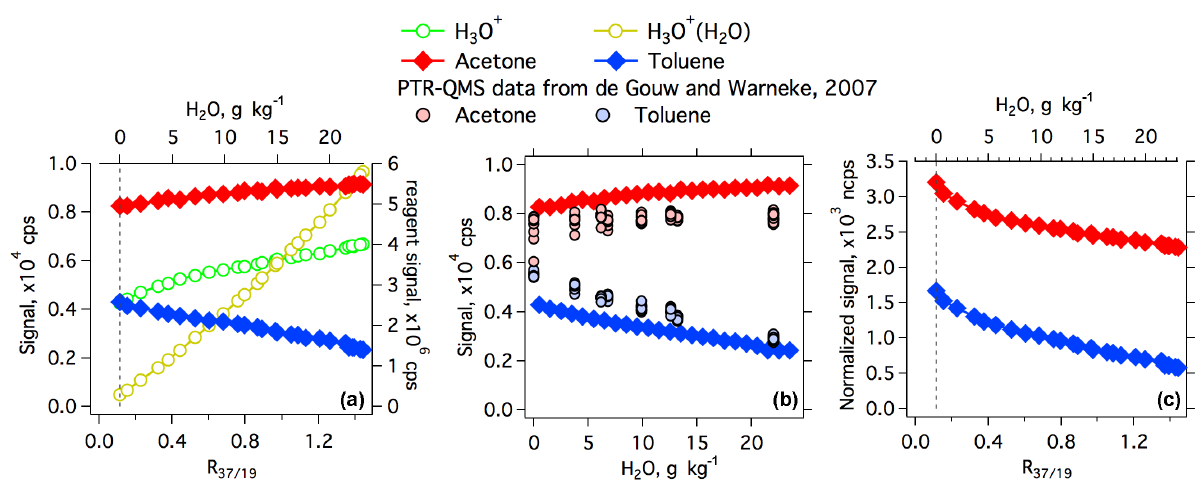
Figure 4. Normalization and humidity dependence of acetone and toluene detection from a laboratory experiment. (a) Background subtracted raw signals of protonated acetone and toluene with mixing ratios of 8.0ppb as the function of R 37 / 19 . The signals of H 3 O + and H 3 O + (H 2 O) are also shown for reference. (b) The humidity dependence of raw signals of acetone and toluene compared with the reported humidity dependence of raw signals of the two compounds in a PTR-QMS from Fig. 6b in de Gouw and Warneke (2007). Note that similar signal levels between the two instruments shown in (b) are coincident. The relative changes at different humidity levels should be compared. (c) Signals of protonated acetone and toluene normalized to the H 3 O + signal as a function of R 37 / 19 . Vertical dashed line in (a) and (b) indicated R 37 / 19 under dry